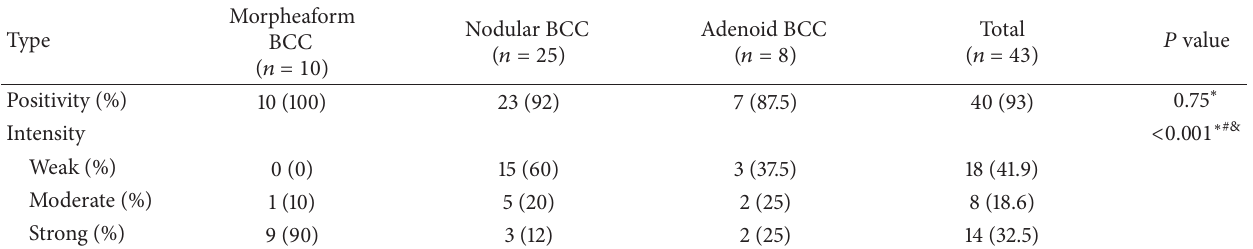
Table 3: Ezrin expression among different types of periocular BCC.